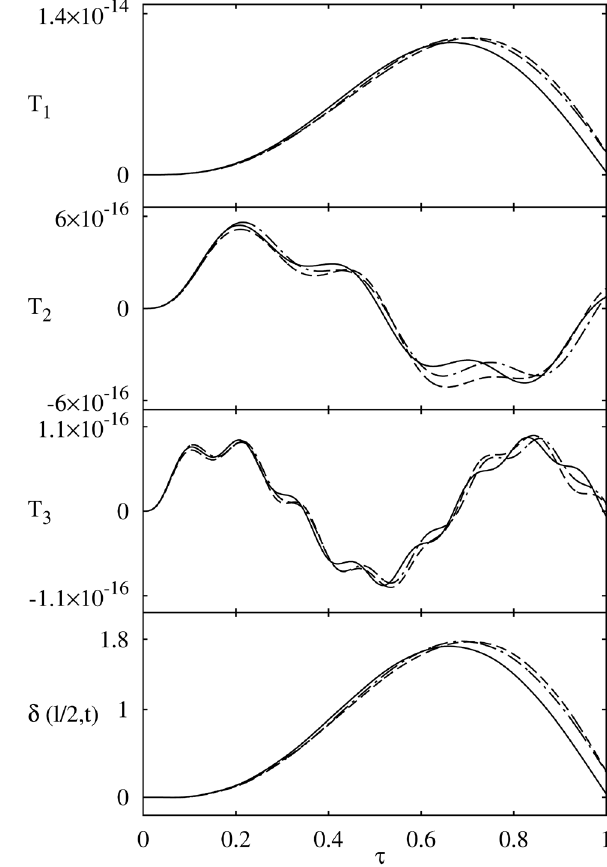
Figure 10 Time functions of the first three natural modes and rela- tive deflections of nanotubes in subresonance, l / d = 10, J = 0, α = 0.1, = 0, µ = 0, γ = 0.01, P / g = m d = 1.621·10 -15 nkg, ____ gravity force; k w i _ . _ gravity and inertia force – harmonic response; _ _ _ gravity and inertia force – parametric response.